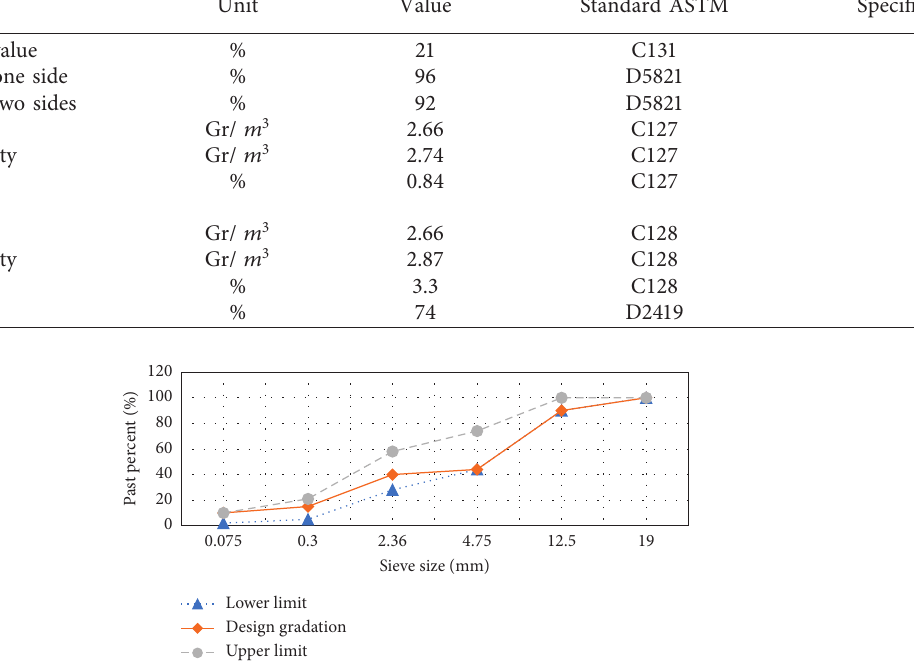
Figure 1: Upper, lower, and selected criteria for aggregate gradation.